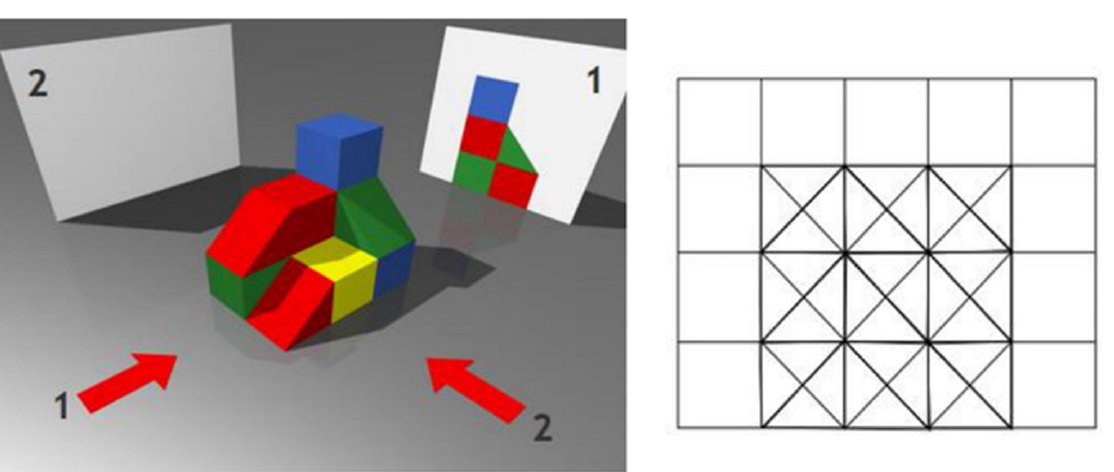
Figure 4. Assignment of Task 2.